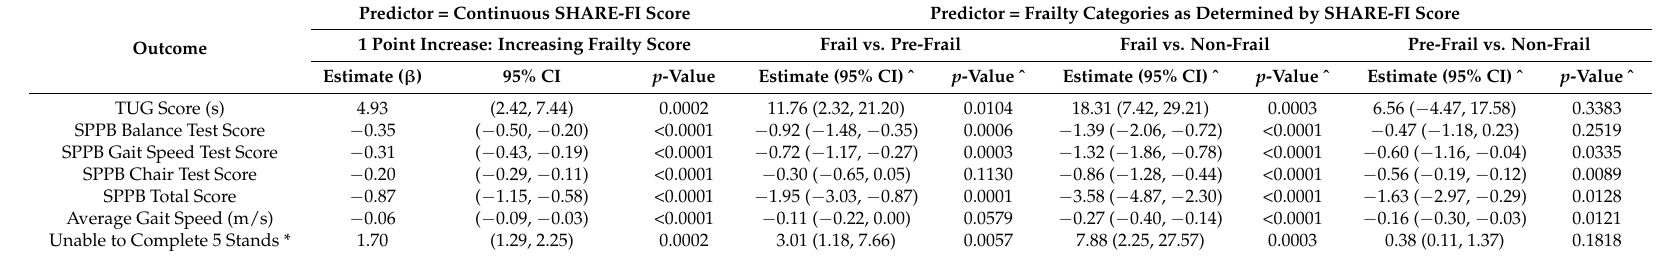
Table 3. Predictive Ability of Survey of Health, Ageing and Retirement in Europe-Frailty Instrument (SHARE-FI) for Physical Performance Measures.